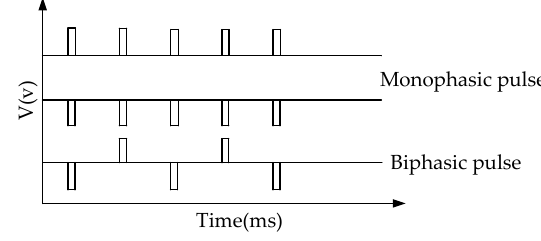
Figure 5. Output waveform of the micro electroporation’s circle.